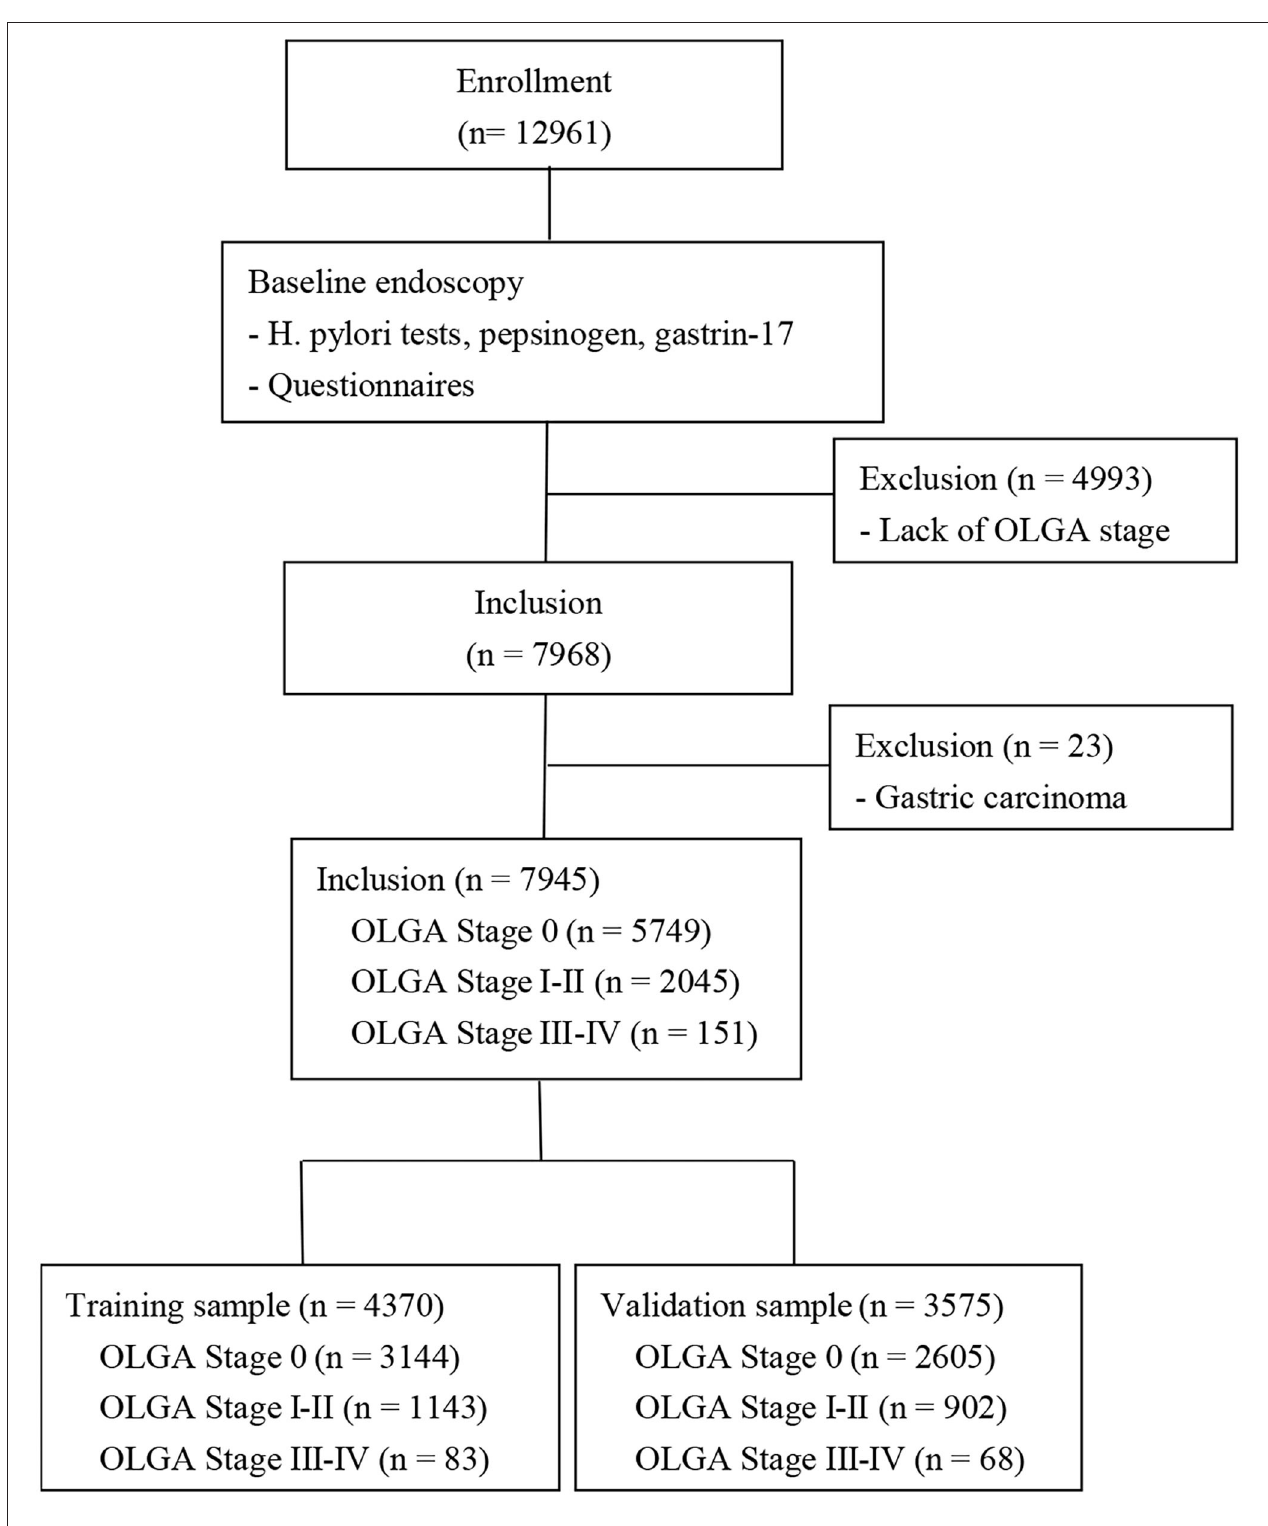
FIGURE 1 | Flow chart for establishing of the training and validation sample. A total of 12,961 participants underwent at our hospital, but 4,993 participants were excluded from the study due to the lack of OLGA stage and 23 participants were excluded due to gastric cancer. Of the remaining 7,945 participants, 4,370 participants were allocated to the training sample and 3,575 participants were allocated to the validation sample. OLGA, operative link for gastritis assessment.